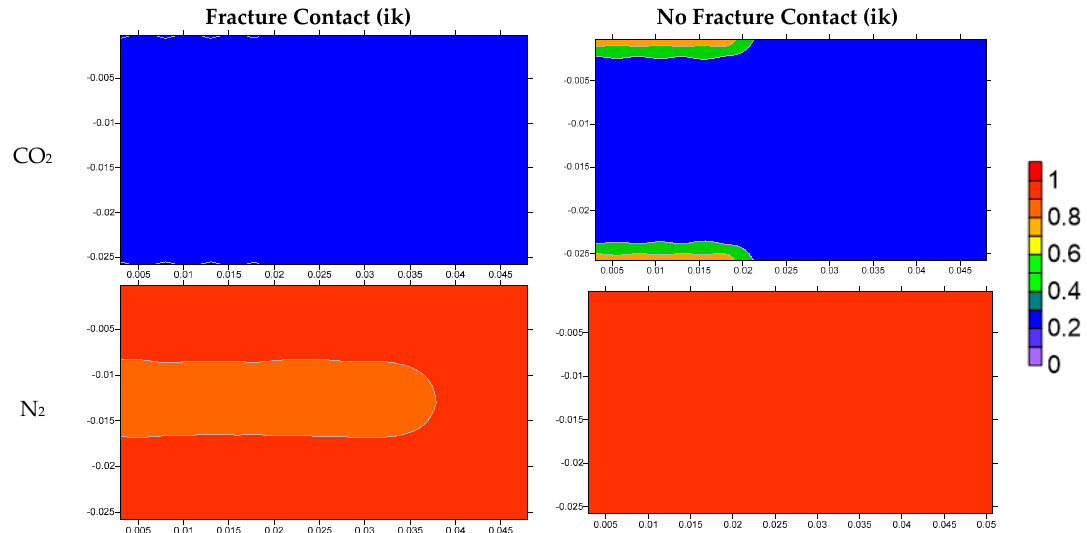
Figure 16. Production component comparison in Case-4.